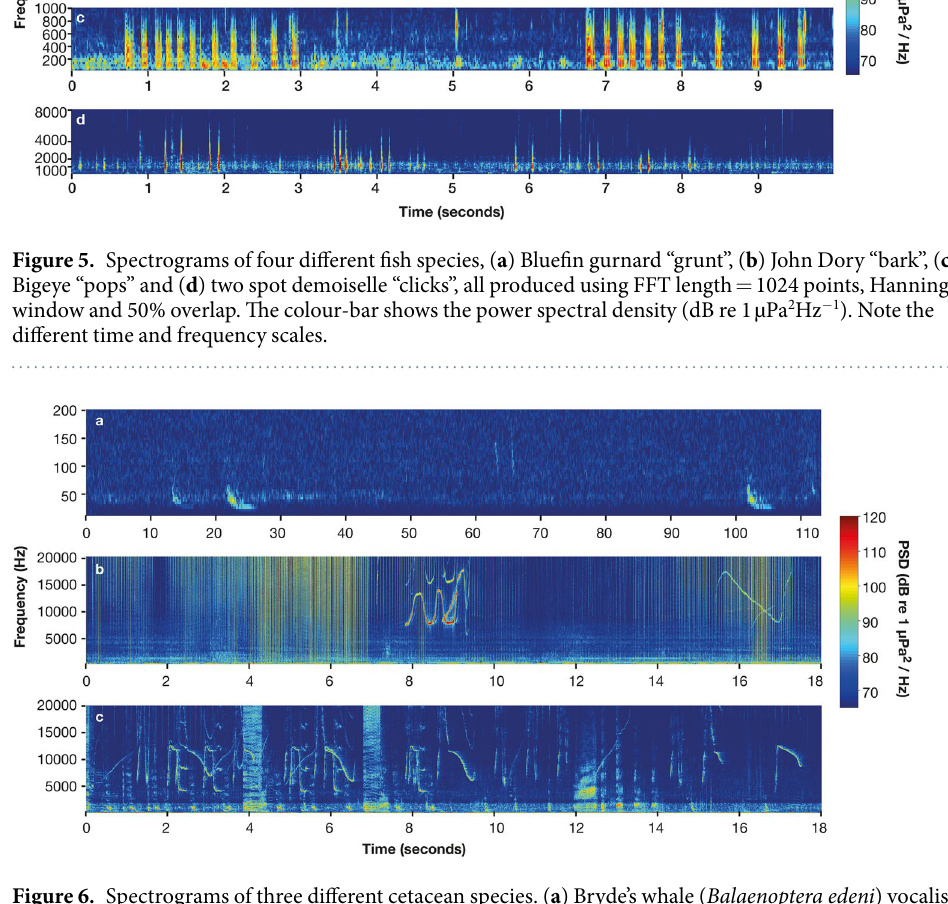
Figure 6. Spectrograms of three different cetacean species. ( a ) Bryde’s whale ( Balaenoptera edeni ) vocalisation downsampled to 8,000 Hz sample rate, FFT length = 1024 points, Hanning window and 50% overlap. ( b ) Common dolphin ( Delphinus delphis ) vocalisations FFT length = 512 points, Hanning window and 50% overlap. ( c ) Bottlenose dolphin ( Tursiops truncatus ) vocalisations FFT length = 512 points, Hanning window and 50% overlap. The colour-bar shows the power spectral density (dB re 1 µ Pa 2 /Hz).Note the different time and frequency